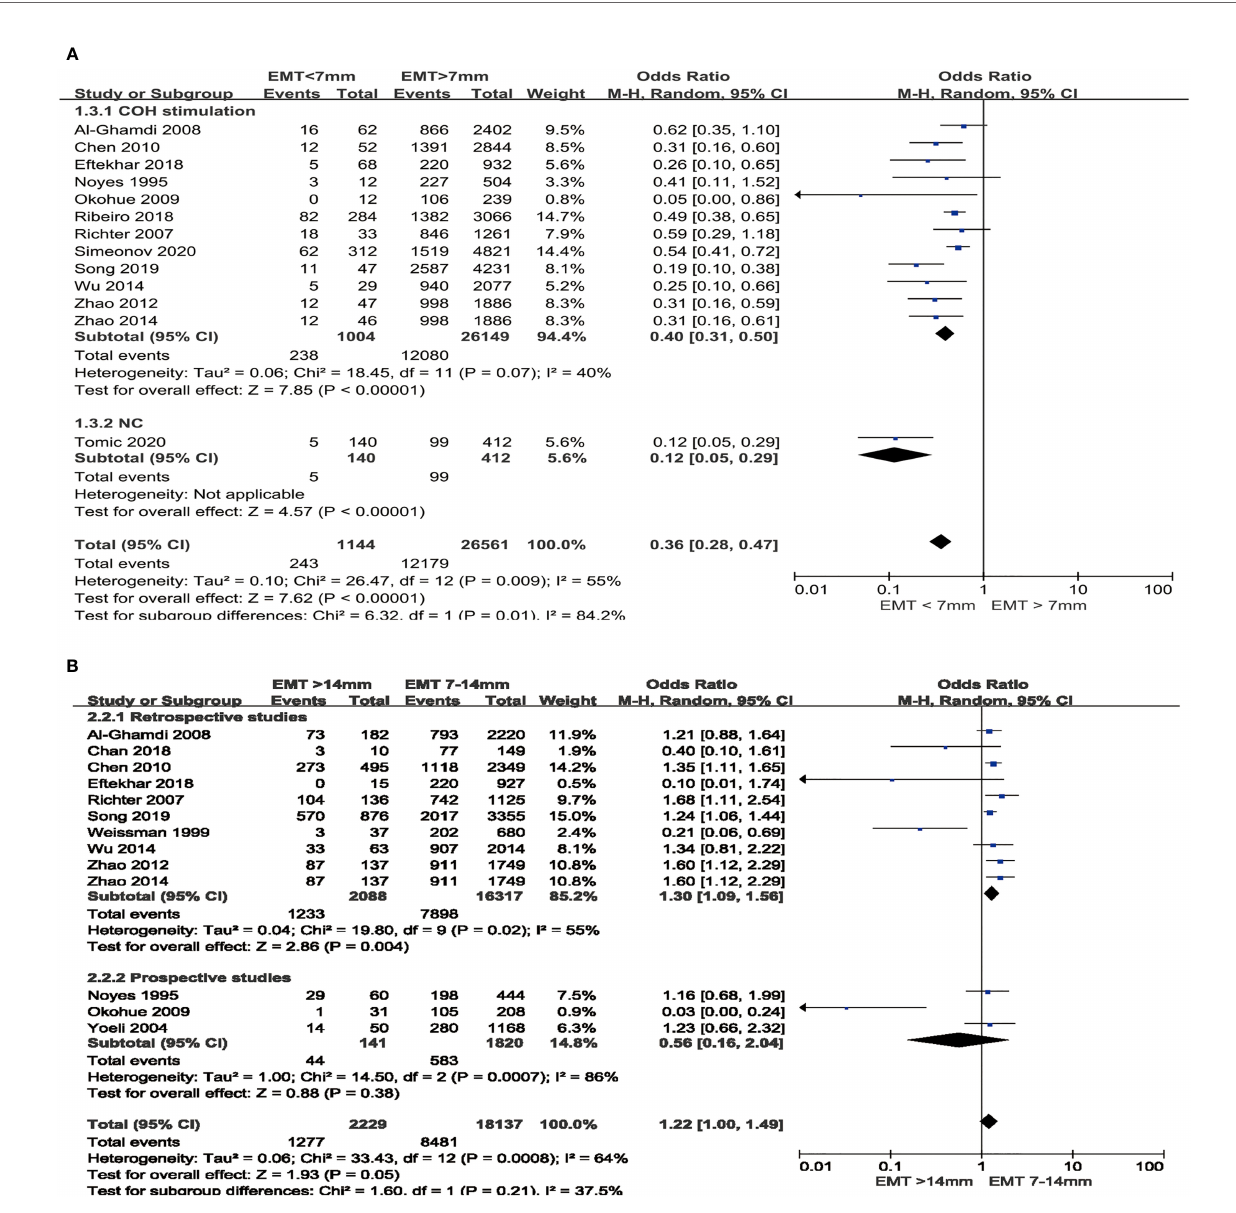
FIGURE 3 | Comparison of CPR between EMT groups in fresh cycles. (A) Comparison between thin endometrium group and non-thin endometrium group. (B) Comparison between thick endometrium group and medium endometrium. CPR, Clinical pregnancy rate; COH, Controlled ovarian hyperstimulation; NC, Natural